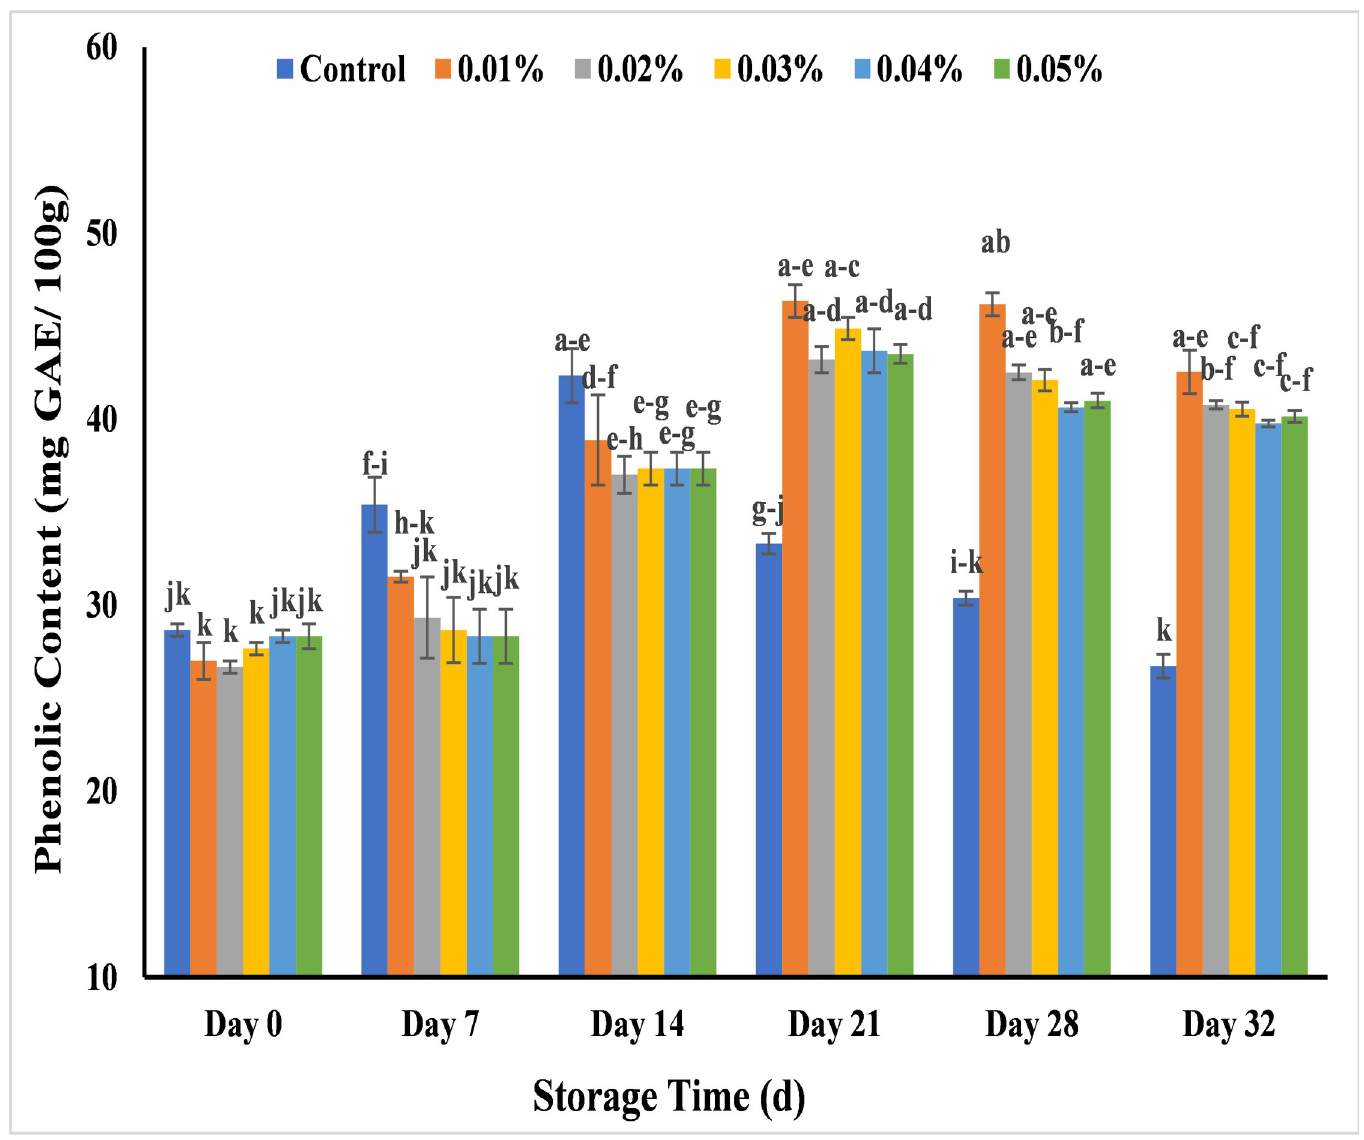
Fig 20. Effect of various AgNPs concentration (T0 = control, T1 = 0.01%, T2 = 0.02%, T3 = 0.03%, T4 = 0.04%, T5 = 0.05%) on phenolic content of Cavendish banana (BASRAI) during 32 days of storage.